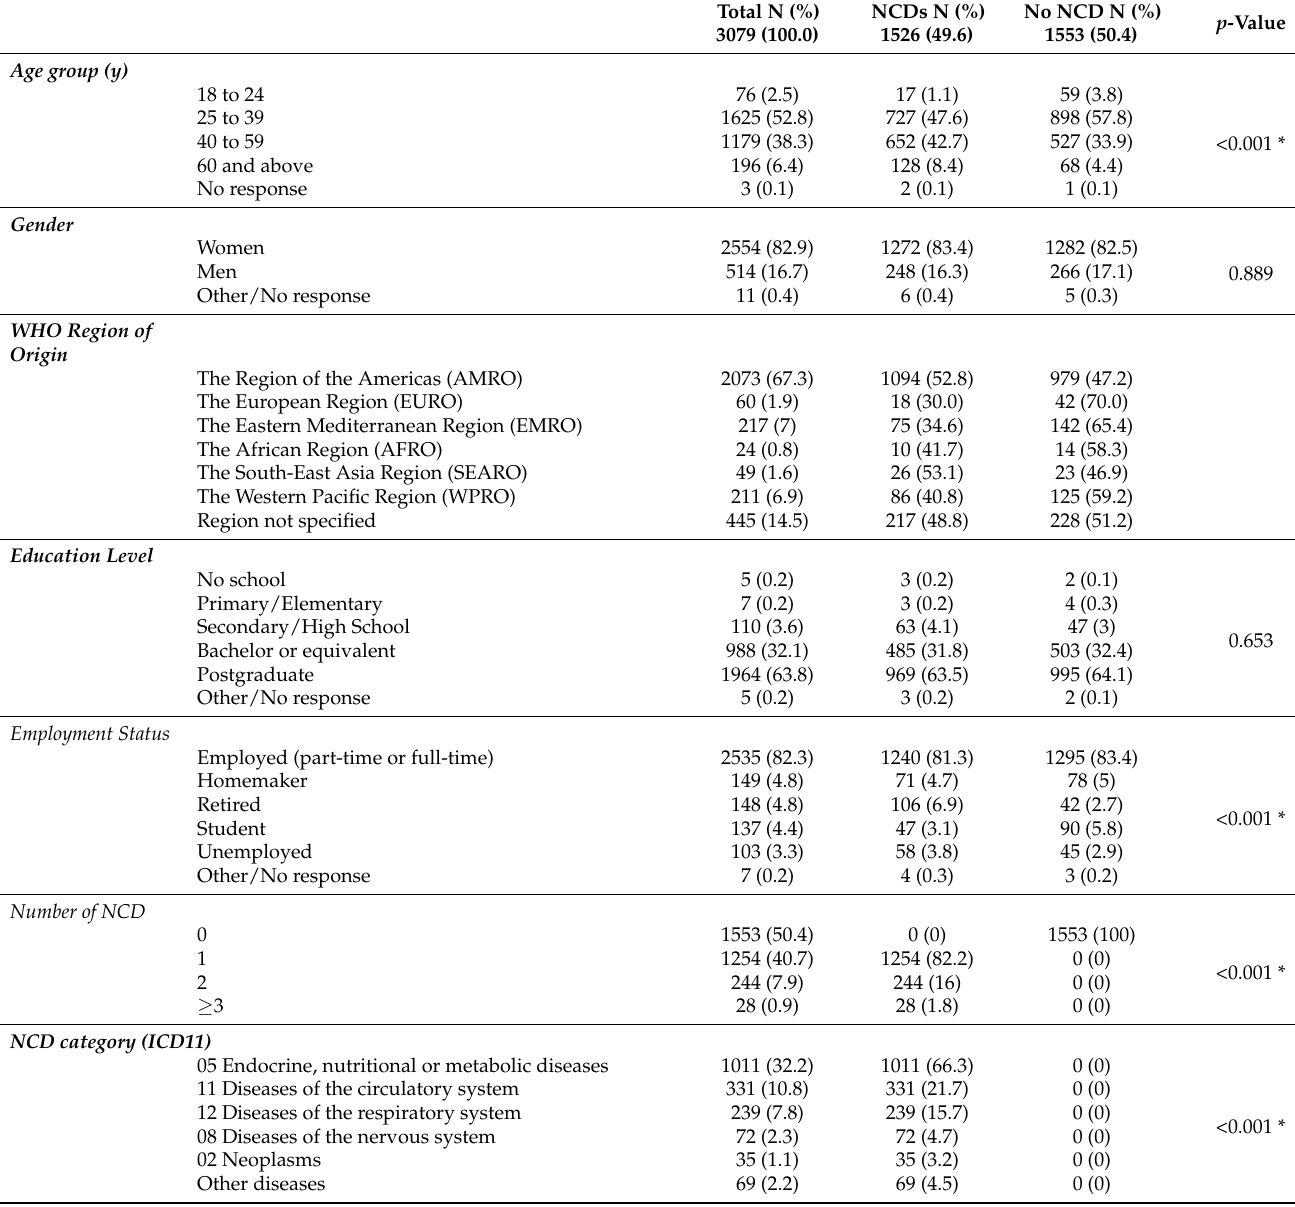
Table 1. Demographic data of survey